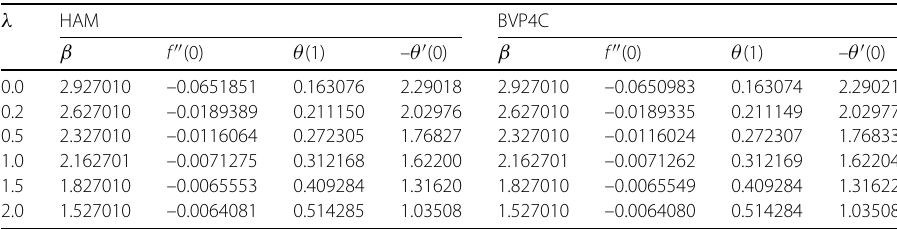
Table 6 Comparison of the values of β = Υ Mathematica package BVPh2.0 approximation and shooting method for the case β = 0.2, I 0 = 0, A = 0.3, N = 0.2, S = 0.4, Ma = 1, M = 1, Pr = 1 and several values of λ